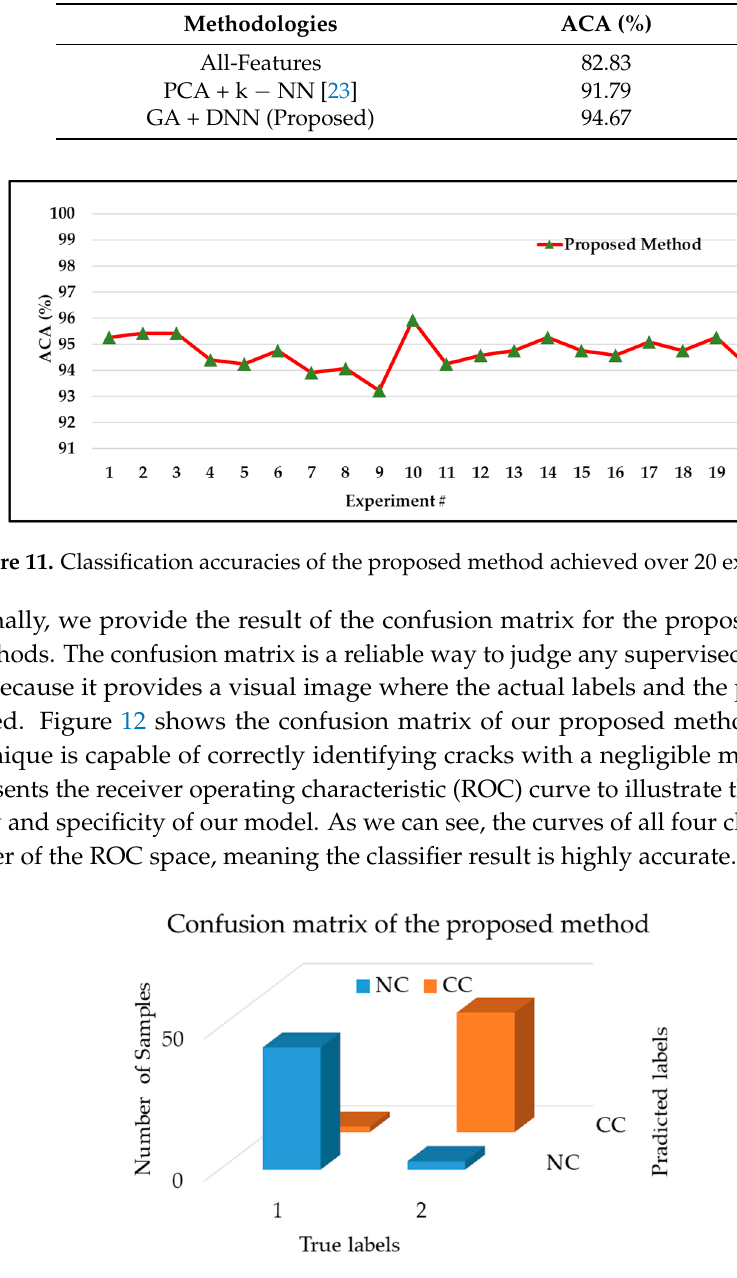
Figure 12. Confusion matrix showing the classification of the proposed method.